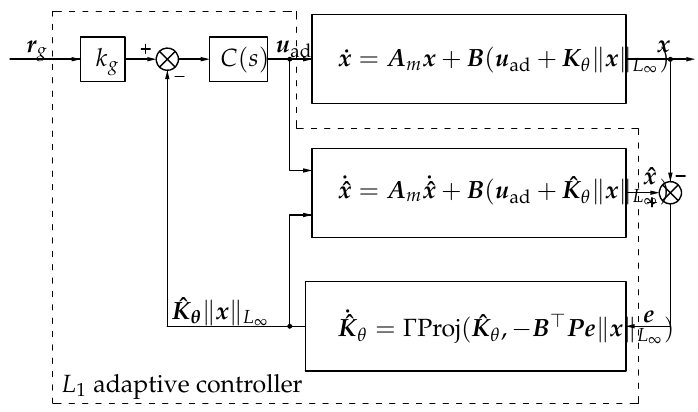
Figure 2. L 1 adaptive control system